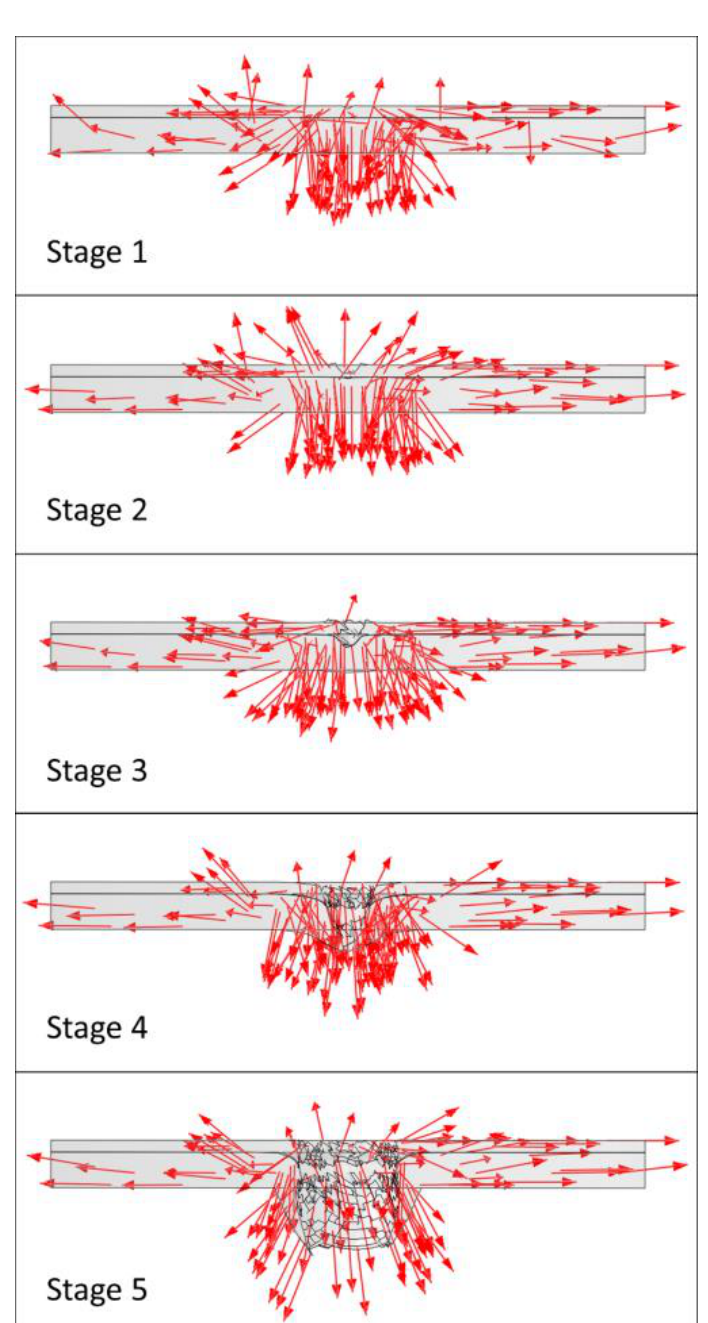
Figure 27. Numerical results of nodal vectors of elements displacement for friction drilled joint at different stages.